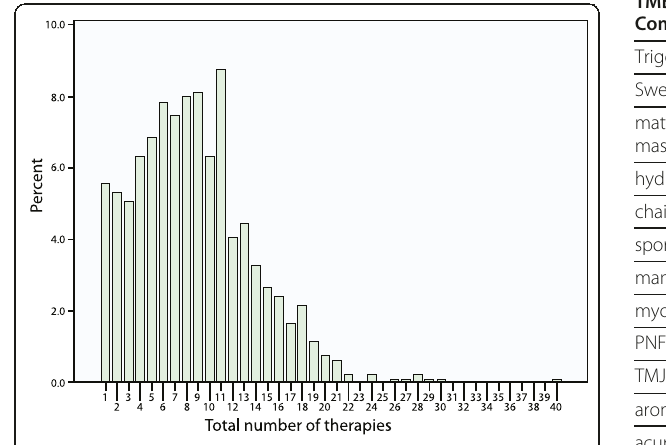
Figure 1 Total number of therapies in which a practitioner has trained .